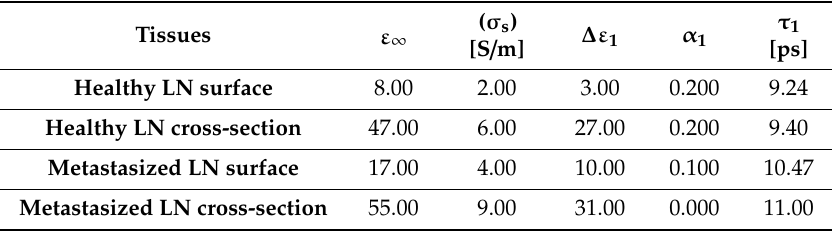
Table A2. Parameters of the Debye model for LNs from [31] suitable to extract dielectric properties at a center frequency of 7.5 GHz, applied to a 1-pole Cole–Cole